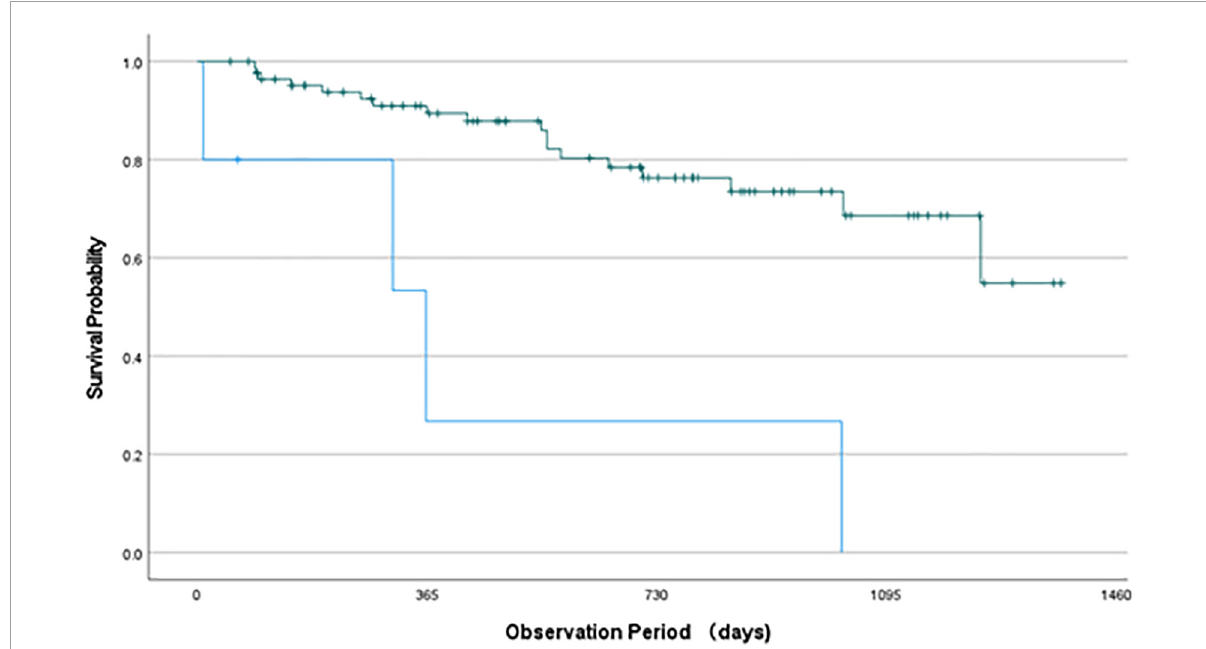
FIGURE1 Survival curve of Kaplan-Meier survival analysis. Green line indicates the work maintenance state of patients absent from work and blue line shows that of unemployed patients. These curves were significantly different (Log-rank test; χ 2 = 17.1, p < 0.001). For example, 2 years after restoration about 80% patients maintained their work (green line) whereas less than 30% patients maintained their work (blue